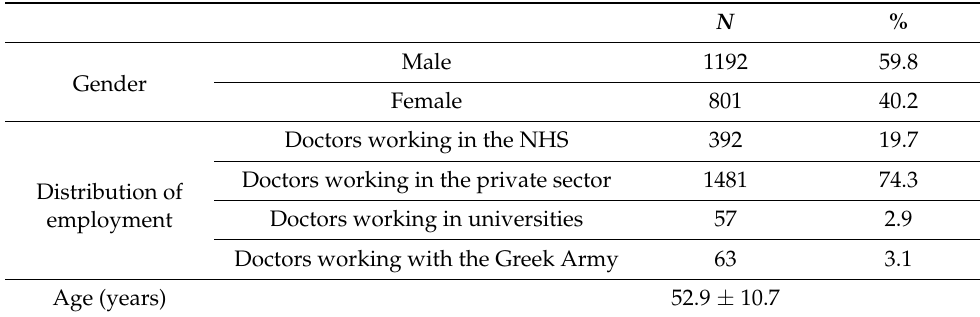
Table 1. Description of